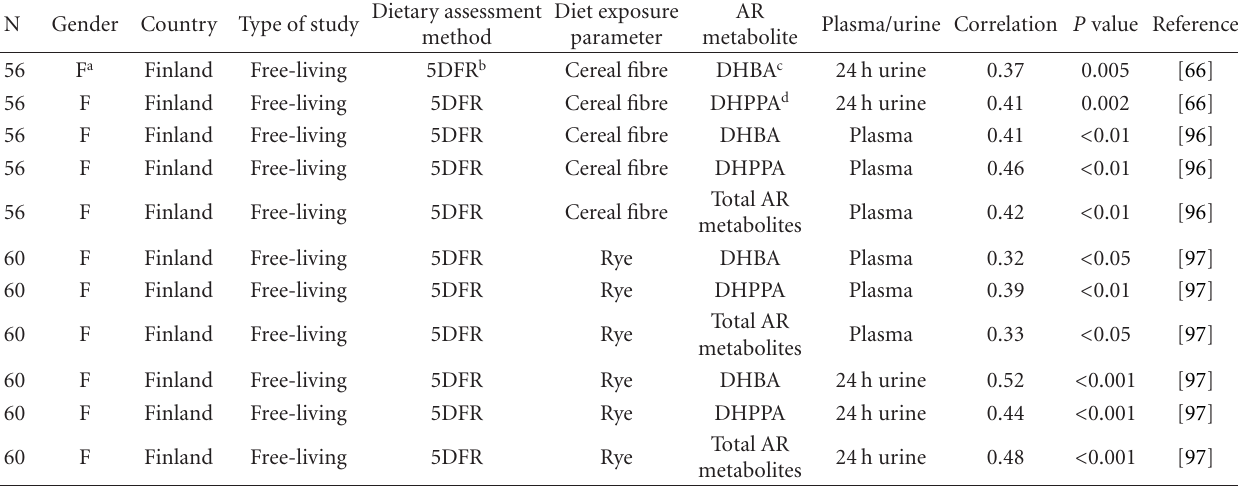
Table 3: Correlations of plasma and urinary alkylresorcinol metabolites (DHBA and DHPPA) with di ff erent measurements of wholegrain intake from previously published studies. Dietary assessment N Gender Country Type of study